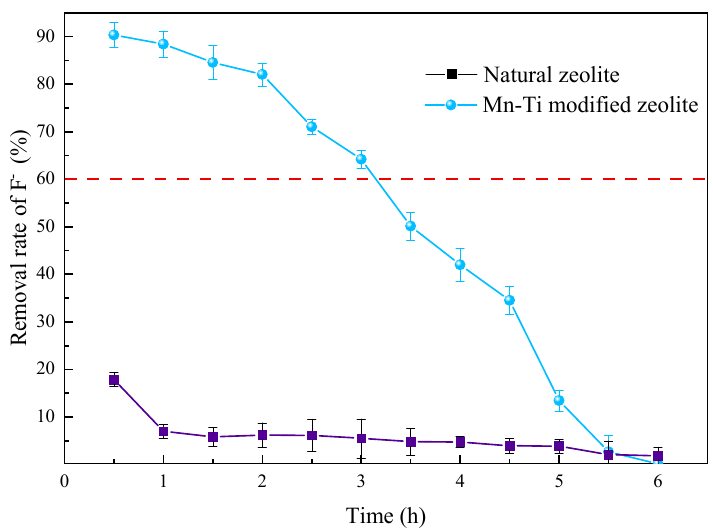
Figure 17. Comparison of adsorbent capabilities of zeolite and modified zeolite in an adsorbent column. The initial fluoride concentration was set to 1 × 10 − 2 g/L. Flow speed was set to 4 mL/min.